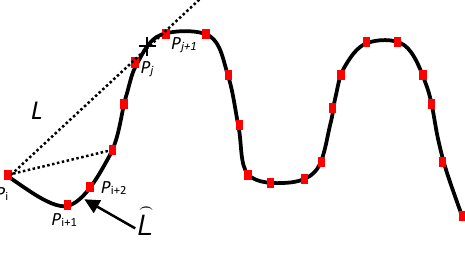
Figure 5. Detailed process of ODC method.